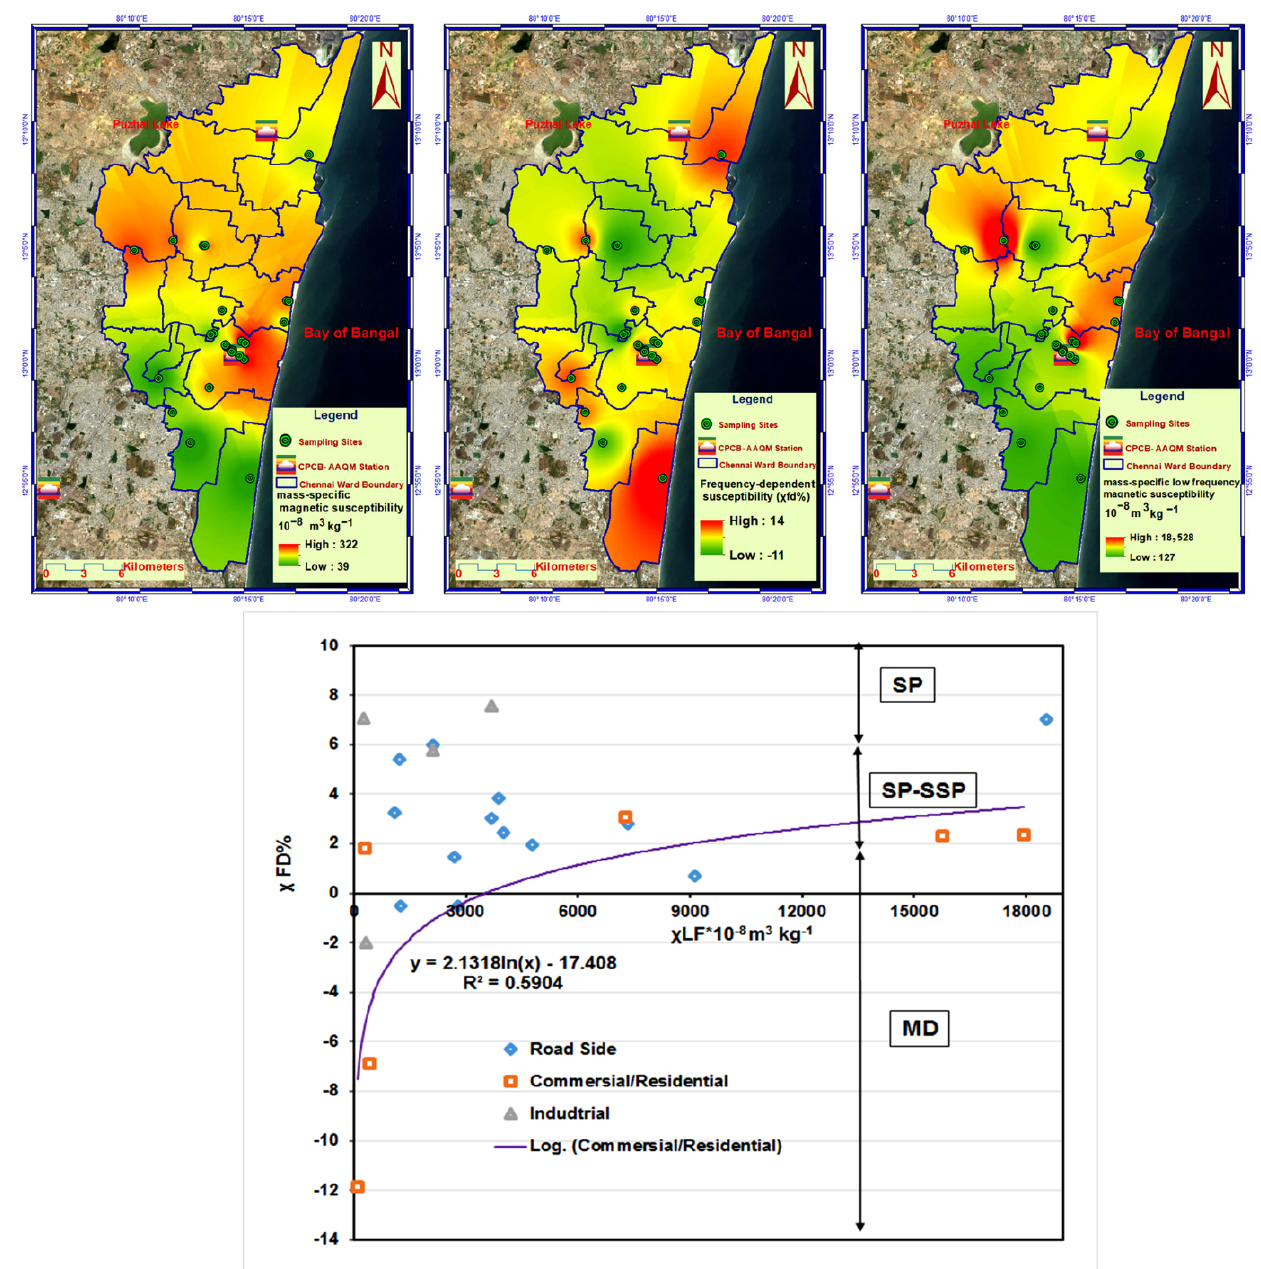
Figure 5. Spatial distribution of environmental magnetic parameters, such as the mass-specific magnetic susceptibility ( χ ), mass-specific low magnetic susceptibility ( χ Lf) and frequency-dependent susceptibility ( χ fd%), in the study area with textural and superparamagnetic (SP) grain size characterization.